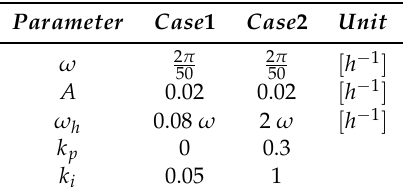
Table 2. PIESC with BOF controller parameters.